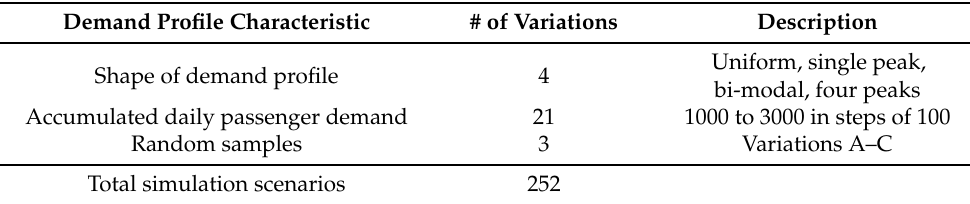
Figure 4. Examples of four shapes of randomly sampled demand profiles: uniform, single peak, bi-modal and four peaks (left to right). Table 2. Study design for demand-related drivers of operations.